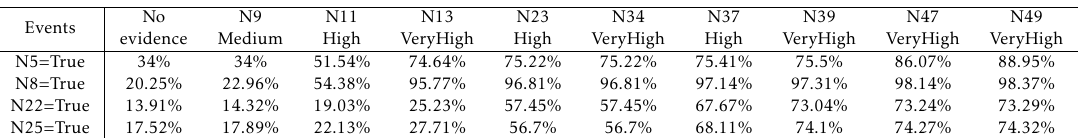
Table 4. Results of Experiment 1